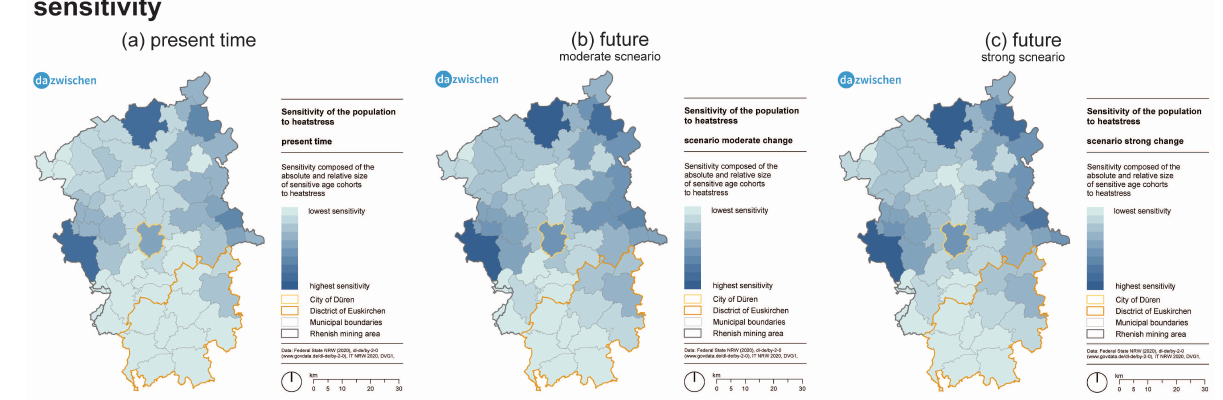
Figure 4. Results for the sensitivity of the indicator “Heat stress of population”: ( a ) Indicator expression for the present time ( b ) Indicator expression for the future under a moderate scenario ( c ) Indicator expression for the future under a strong